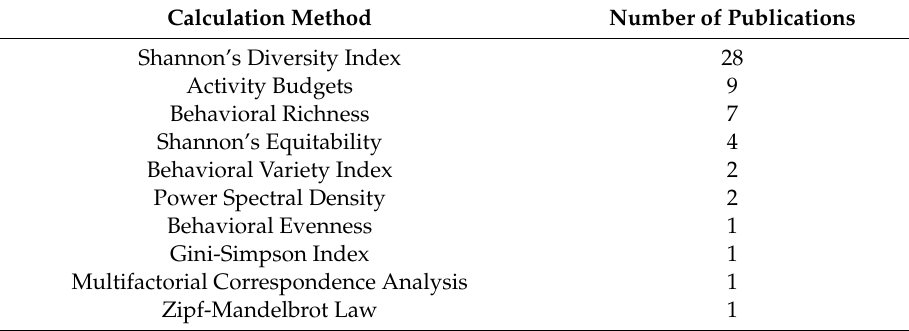
Table 1. Number of publications that include each calculation method for behavioral